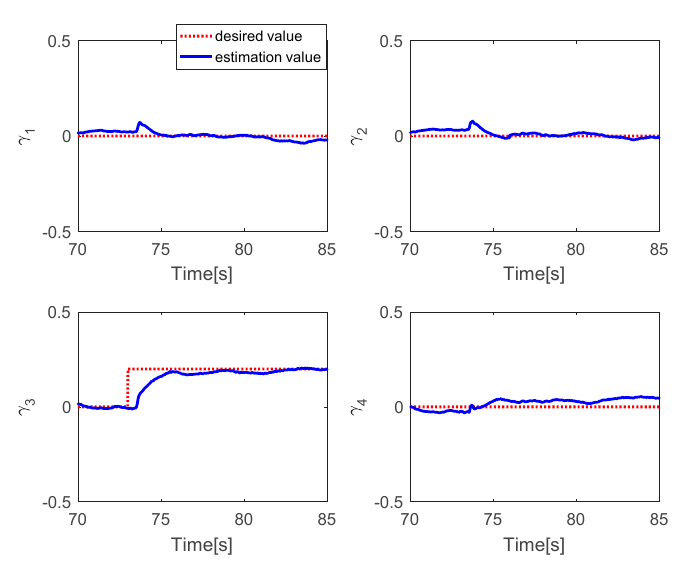
Figure 10. Fault estimation of each actuator.